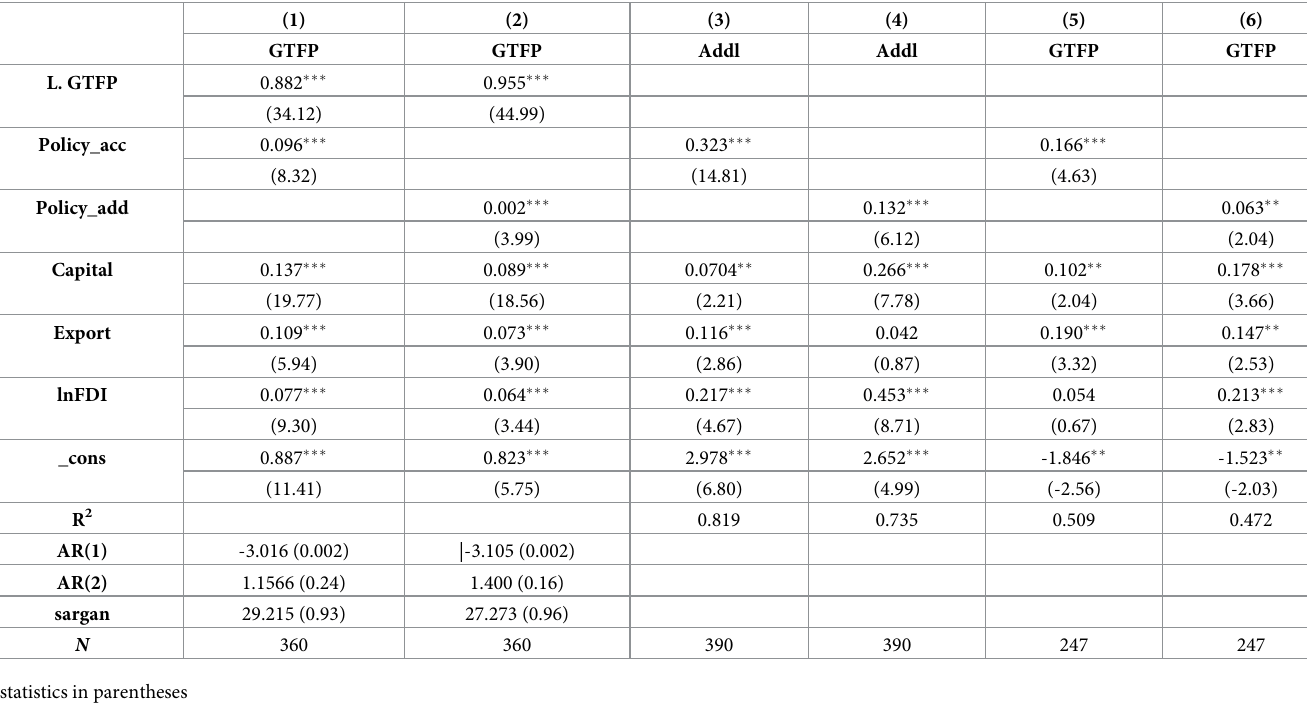
Table 3. Robustness